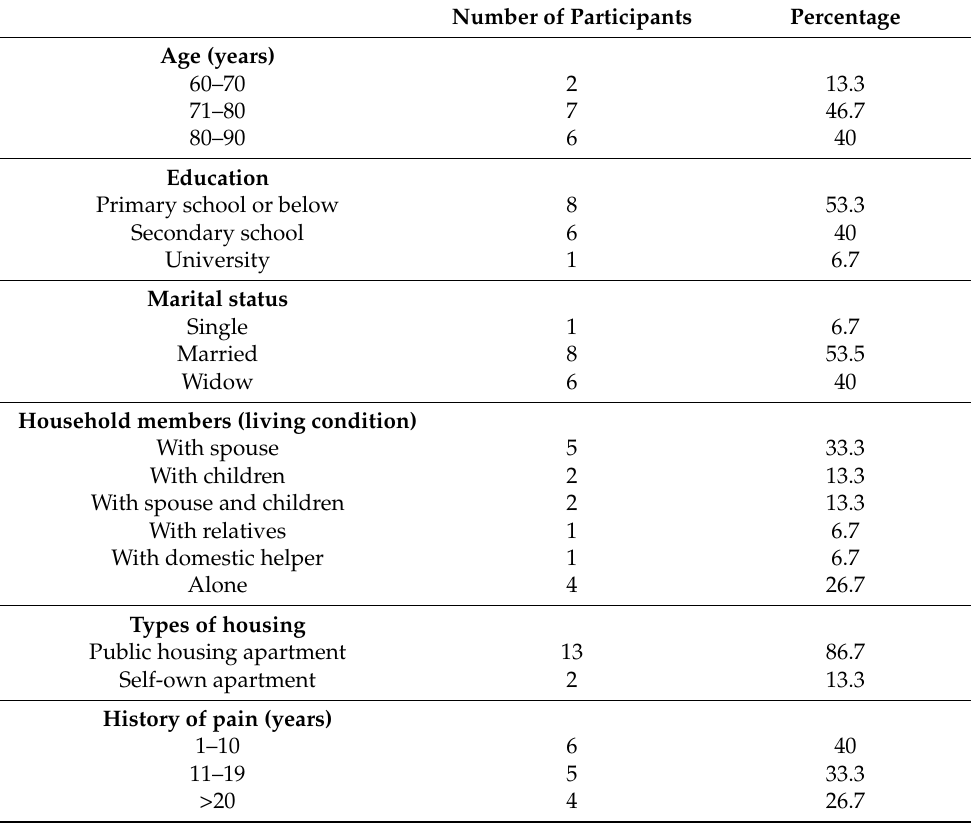
Table 1. Demographic information of